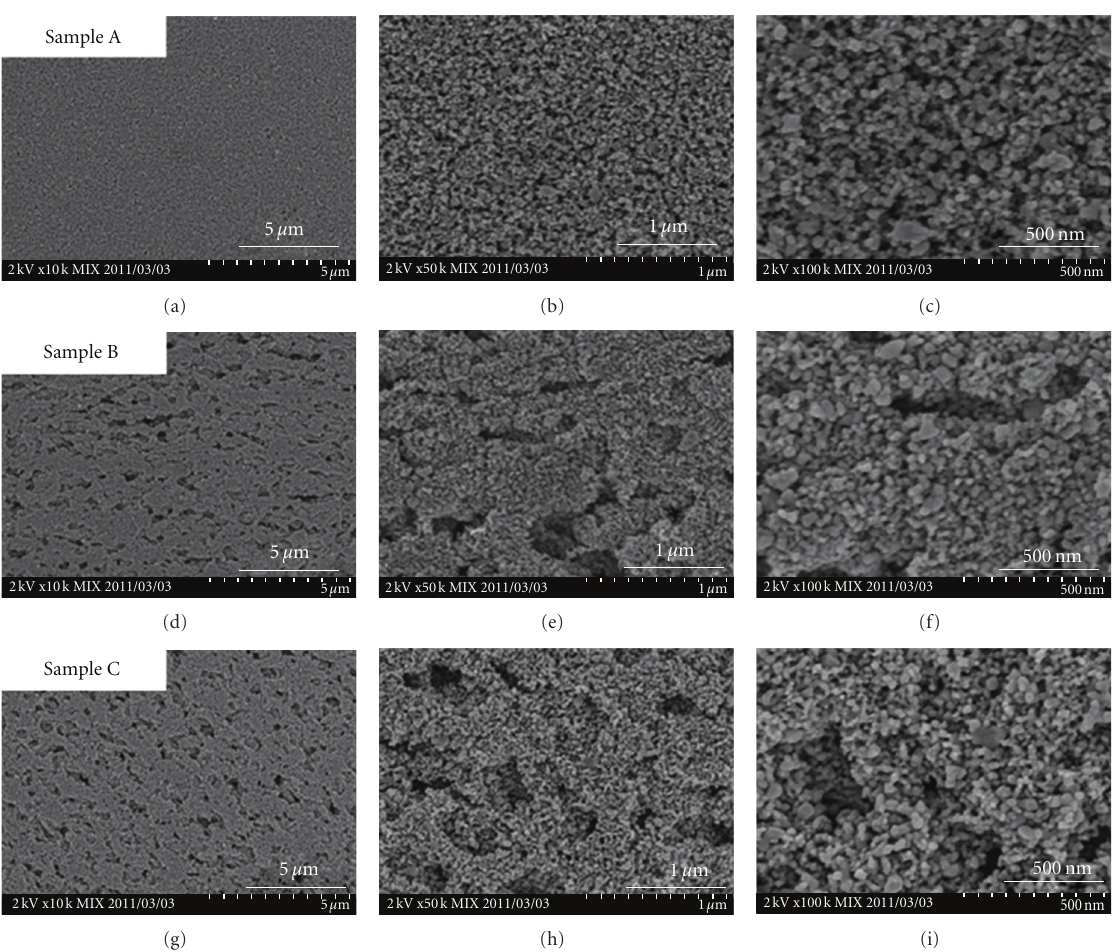
Figure 7: FE-SEM micrographs showing the surface morphology of the TiO 2 layers. The mean particle size of samples A, B, and C were 42.4, 56.9, and 73.4 nm,